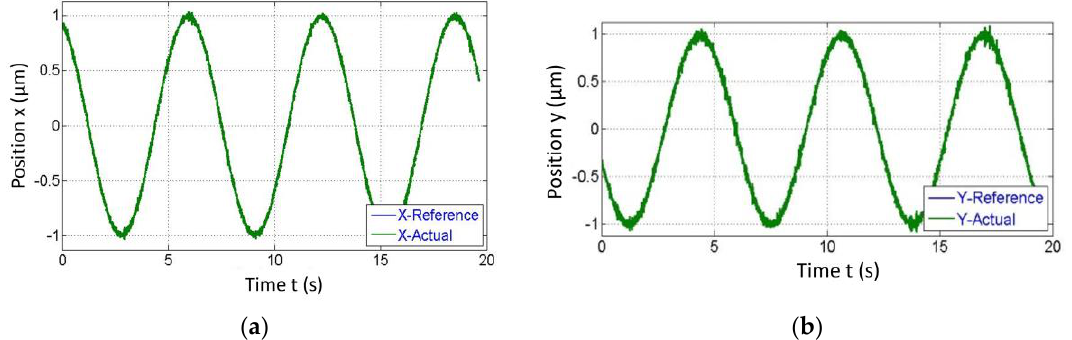
Figure 21. Separate outputs from the algorithm in each the ( a ) X and ( b ) Y direction for tracking a circle of diameter 2mm.